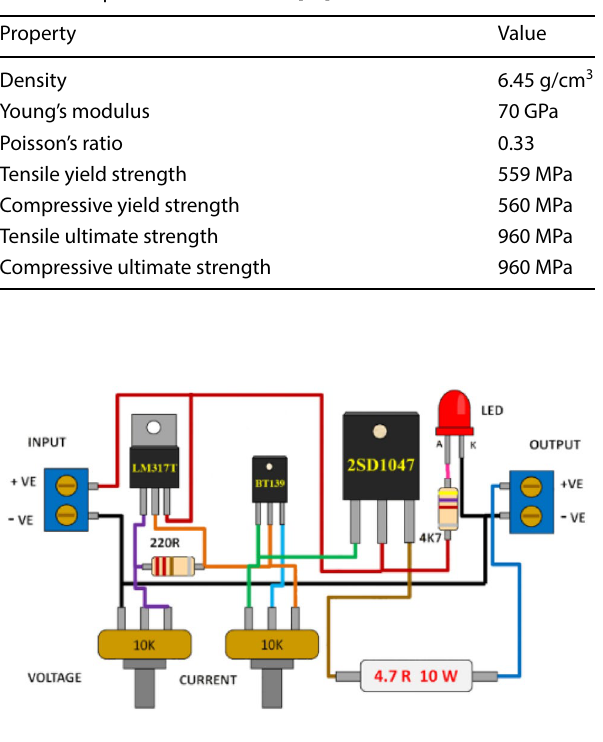
Fig. 5 Circuit diagram of variable DC power supply